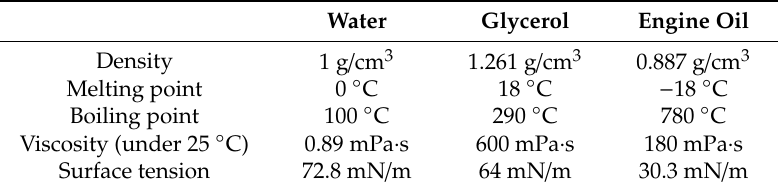
Table 2. Physical properties of the different liquids used in this work.